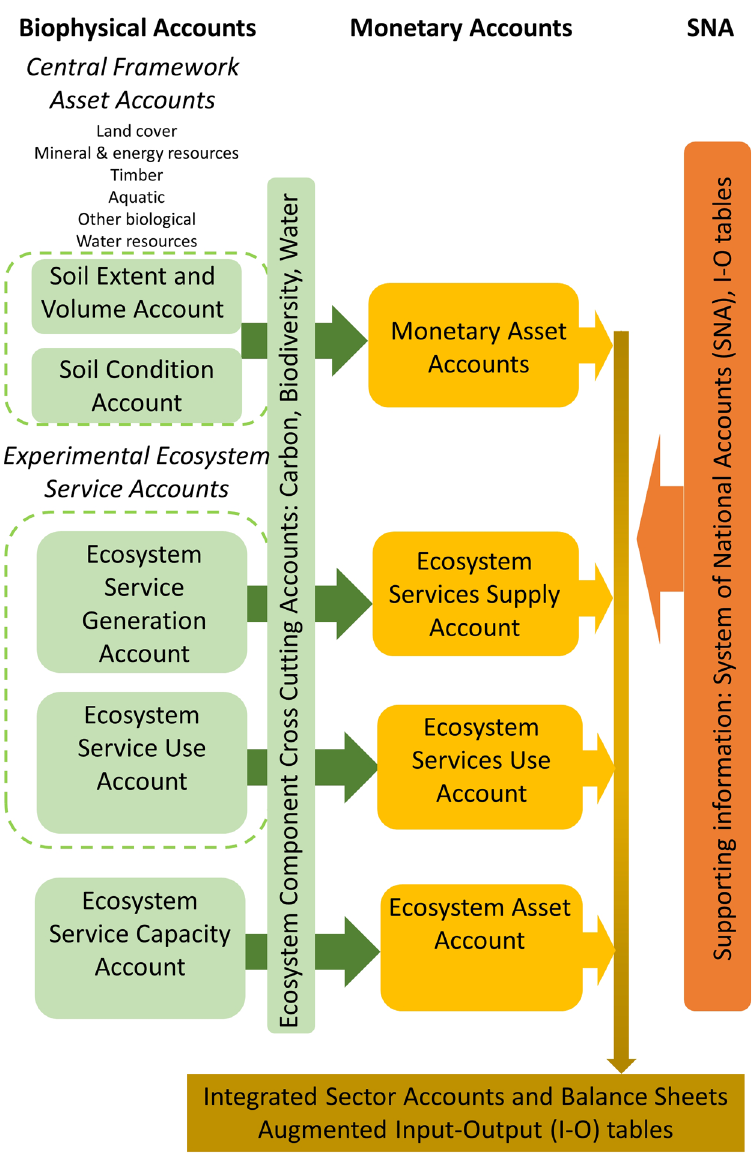
Figure 1. Conceptual overview of the SEEA accounting framework including the Central Framework 6 (SEEA-CF) and the Experimental Ecosystem Service accounts